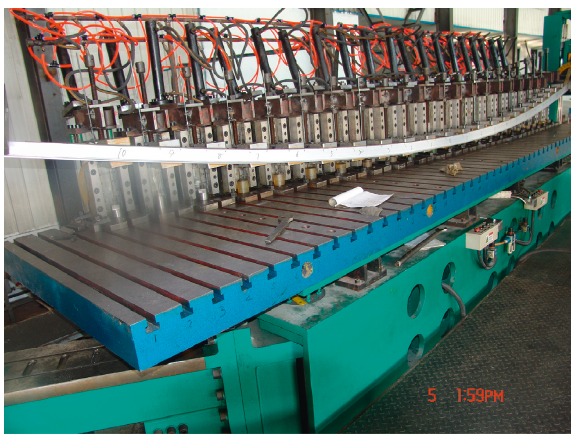
Figure 8: The detection setup and the forming part through the MPSB process.